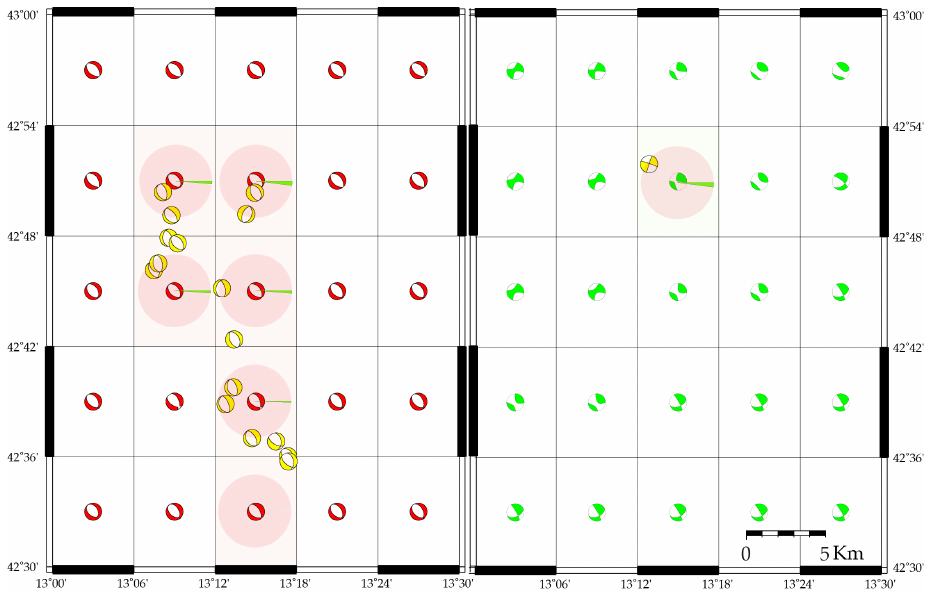
Figure 2 : Location map of Amatrice seismic sequence focal mechanisms (yellow beach-balls). The forecast beach balls are prevalently NF (red) and prevalently SS(green) in the left and right panel, respectively. The cells with the pie charts are used for the comparison. The slices of pie charts in the centre of cells show the percentage associated to normal (red slic- es) and strike-slip (green slices) expected stress regime that is mainly NF with a SS percentage in the range 0 - 10 % (or less than 10%).